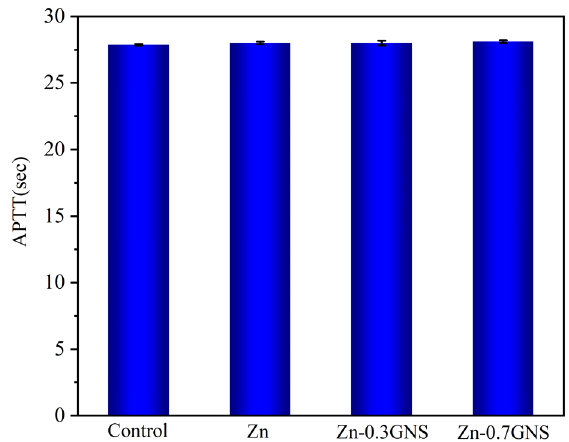
Figure 3. Coagulation time of pure Zn and Zn-GNS composites.